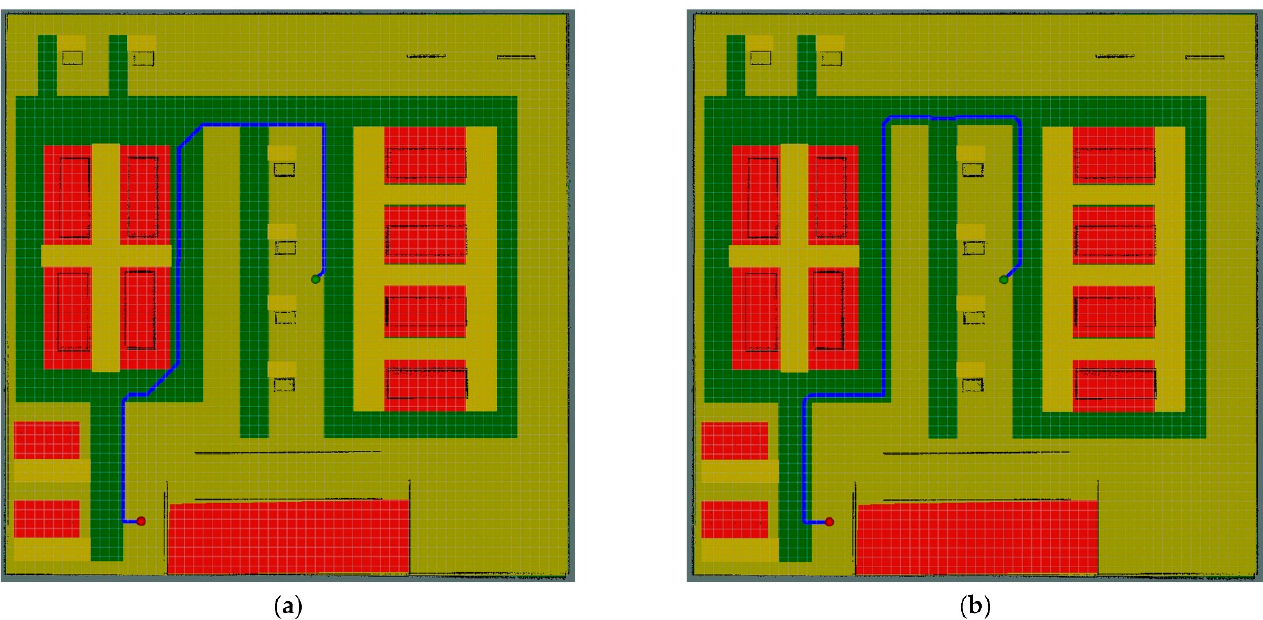
Figure 6. A* based global path planning in a 60 × 60 m sized grid-based costmap. ( a ) Default behavior; ( b ) right driving behavior.